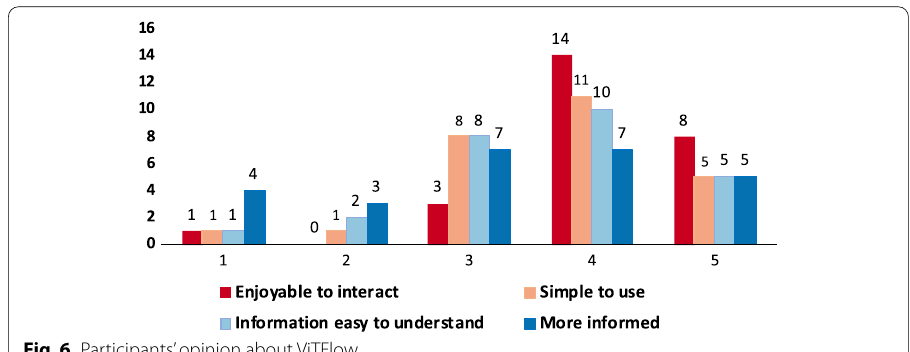
Fig. 6 Participants’ opinion about